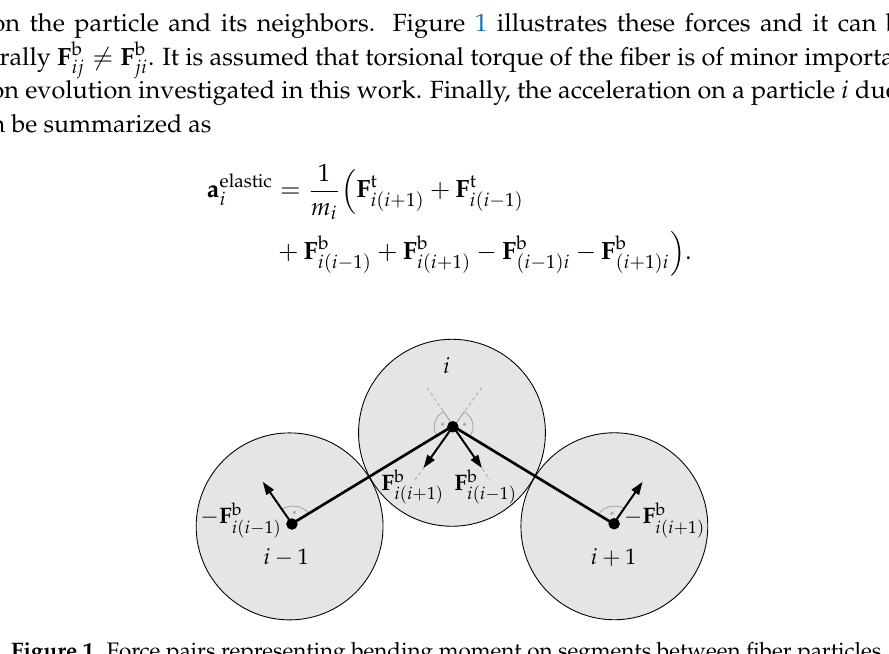
Figure 1. Force pairs representing bending moment on segments between fiber